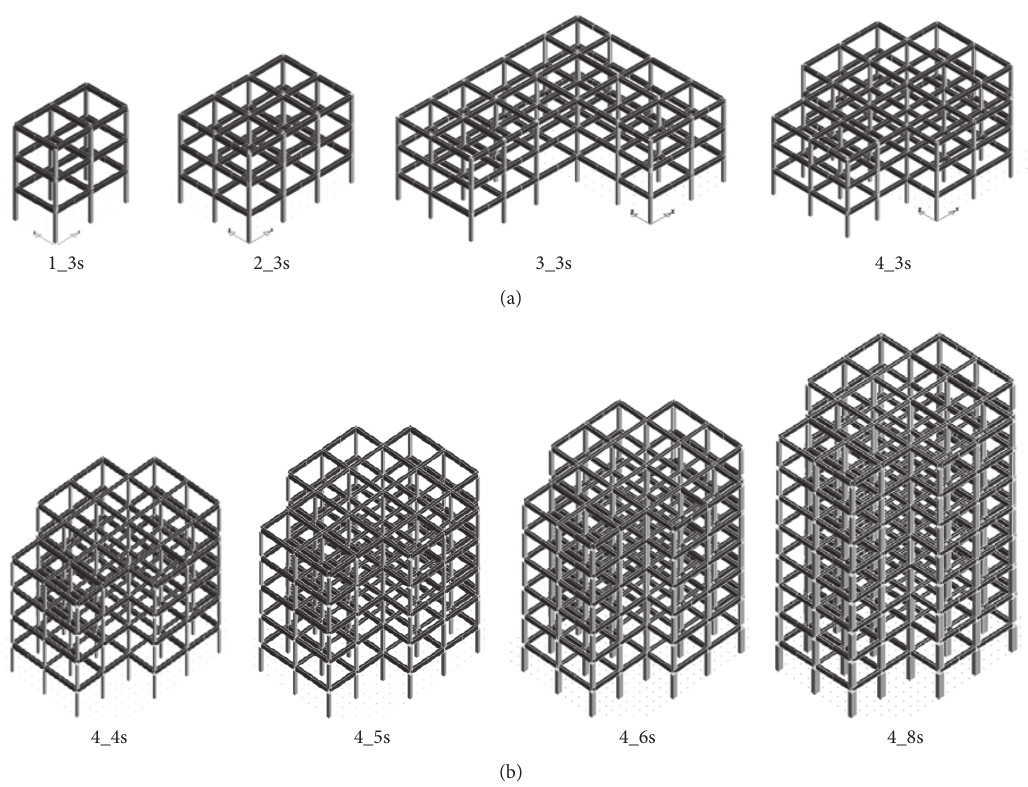
Figure 9: Numerical model of the bare structures: (a) 3 storey structural types and (b) different number of storeys of structural type